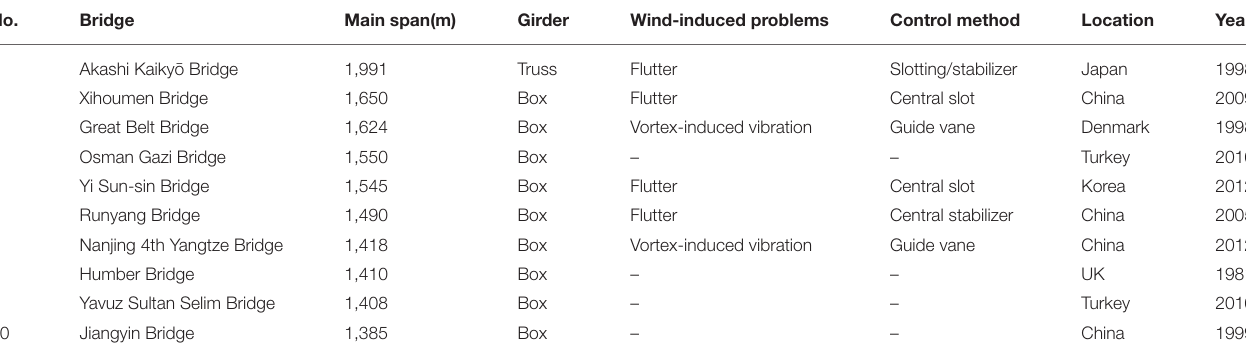
TABLE 1 | Ten longest span suspension bridges in the world.